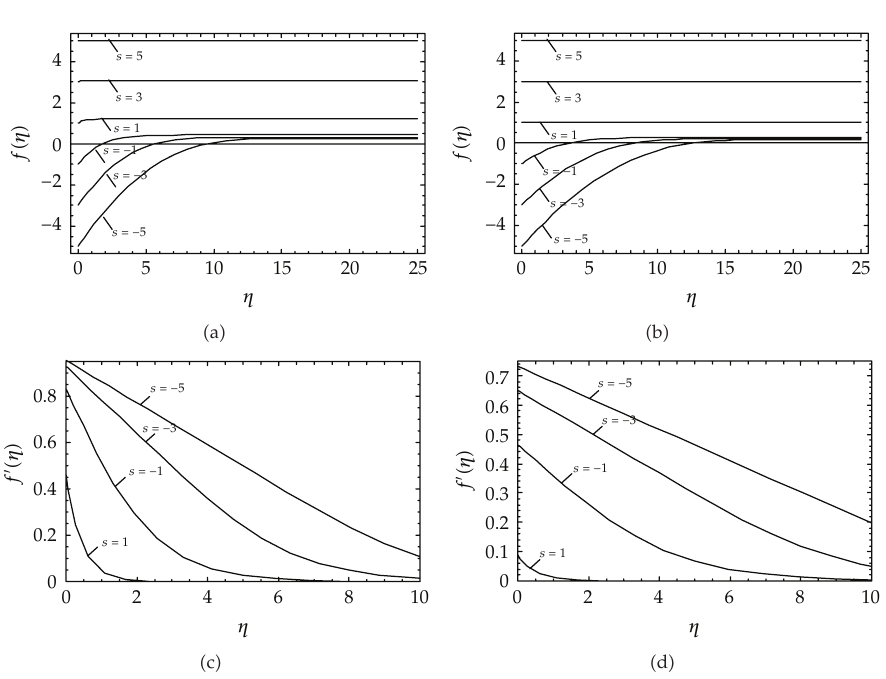
Figure 2: ChPDM solutions when m (cid:8) 2 at (cid:3) a (cid:4) λ (cid:8) 0 . 5 (cid:3) exactly same as Figures 2 (cid:3) c (cid:4) and 3 (cid:3) c (cid:4) in (cid:5) 11 (cid:6)(cid:4) and (cid:3) b (cid:4) λ (cid:8) 5 (cid:3) exactly same as Figures 2 (cid:3) d (cid:4) and 3 (cid:3) d (cid:4) in (cid:5) 11 (cid:6)(cid:4) for various values of s , in injection and suction